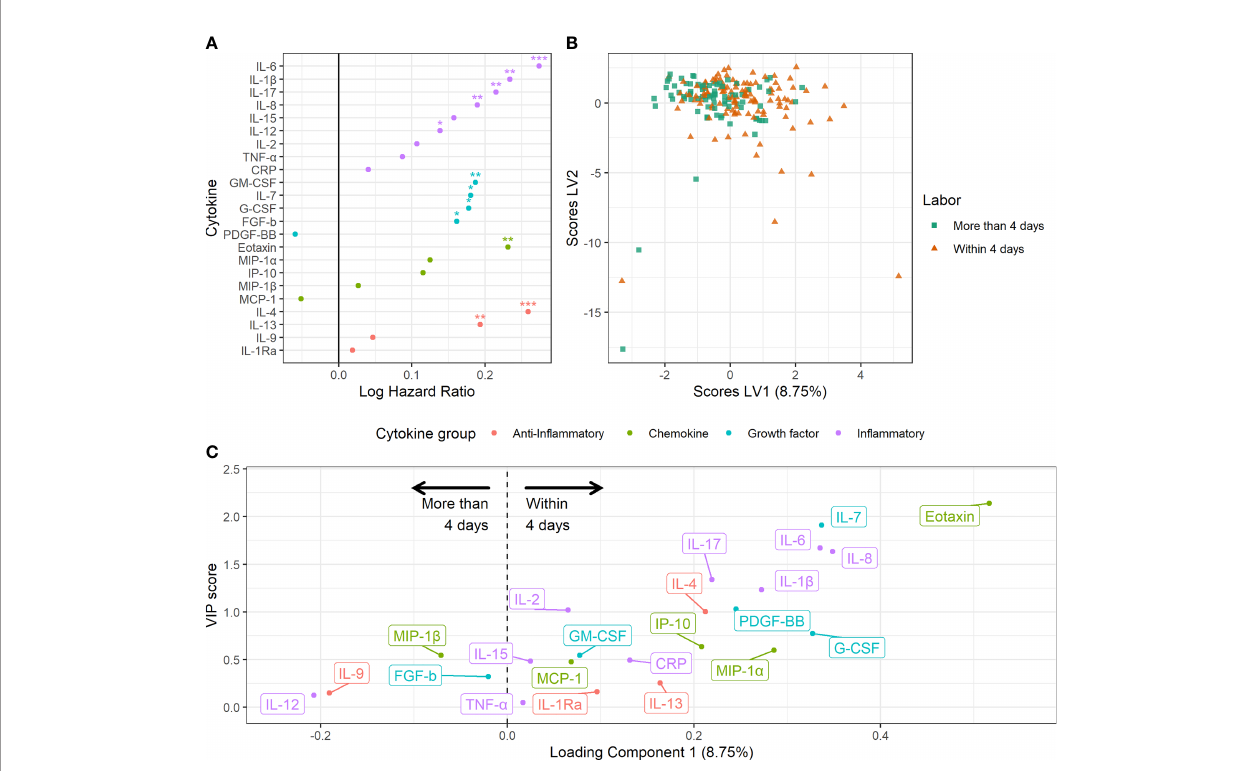
FIGURE 3 | Maternal serum cytokine pro fi les in late term pregnancies approaching labor. (A) Association between serum cytokine levels and risk hazard ratio for spontaneous labor. Estimation from Fine and Gray ’ s proportional subdistribution hazards regression model in late term women. * P < 0.05, ** P < 0.01, *** P < 0.001. (B) Orthogonalized PLS-DA scores for women with spontaneous labor within four days and women with spontaneous labor or induction after more than four days. (C) Variable loadings for the PLS-DA model. Cytokines with positive loadings were increased in pregnancies with spontaneous labor within four days. Higher variable of importance for projection (VIP) scores correspond to higher importance for